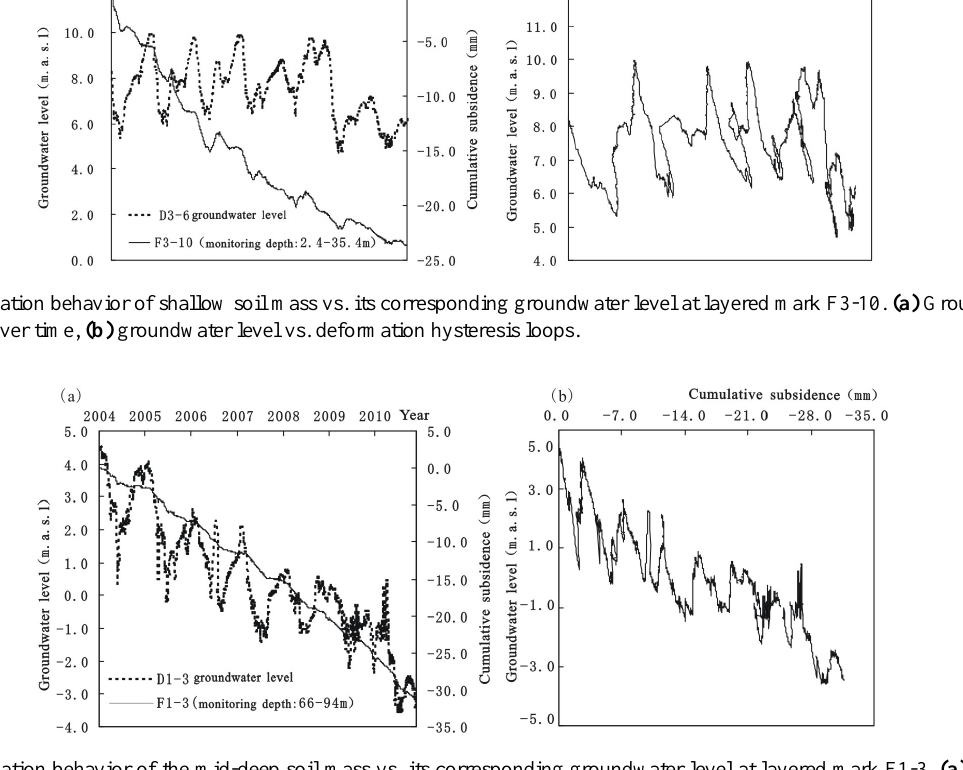
Figure 4. Deformation behavior of the mid-deep soil mass vs. its corresponding groundwater level at layered mark F1-3. (a) Groundwater level and deformation over time, (b) groundwater level vs. deformation hysteresis loops.